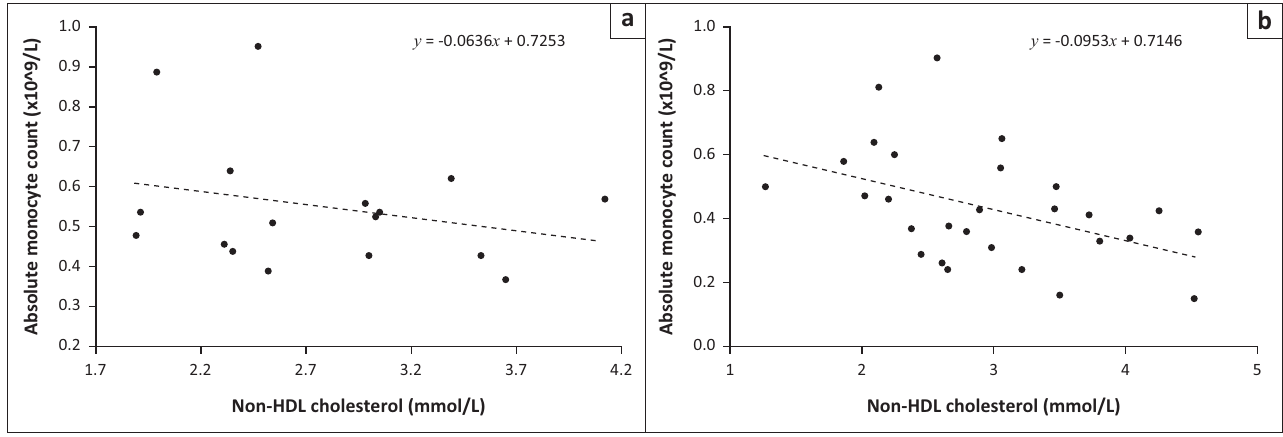
FIGURE 1: Monocyte depletion in HIV infection was inversely associated with increased non-HDL cholesterol, Julia Molefe Clinic. This relationship was weaker in Lu b antigen- negative patients (a) but enhanced in Lu b -positives (b). (a: r = -0.259, p = 0.315 versus b: r = -0.442, p = 0.018). Julia Molefe Clinic, Gaborone, Botswana, December 2016 — February 2017.